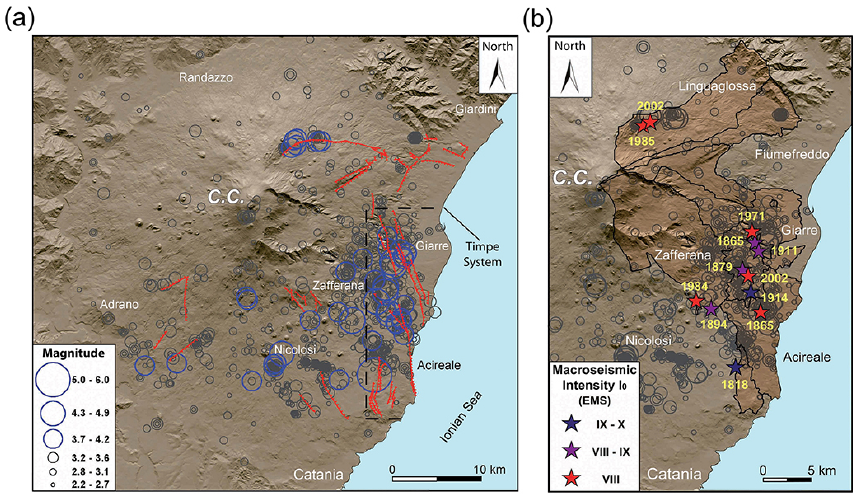
Figure 1. (a) Distribution of Etna earthquakes occurred between 1669 and 2008 (Azzaro et al., 2010). In blue the epicenters of earthquakes of magnitude M ≥ 3 . 7, corresponding to an epicentral intensity I 0 ≥ VII EMS, in gray smaller events ( I 0 ≤ VII EMS). The red lines indicate major faults outcropping (dashes on the low side); (b) earthquakes with epicentral intensity I 0 ≥ VIII EMS-98, corresponding to a magnitude M ≥ 4.1, occurred from 1669 to 2008 in the Acireale and surrounding areas (Azzaro et al.,